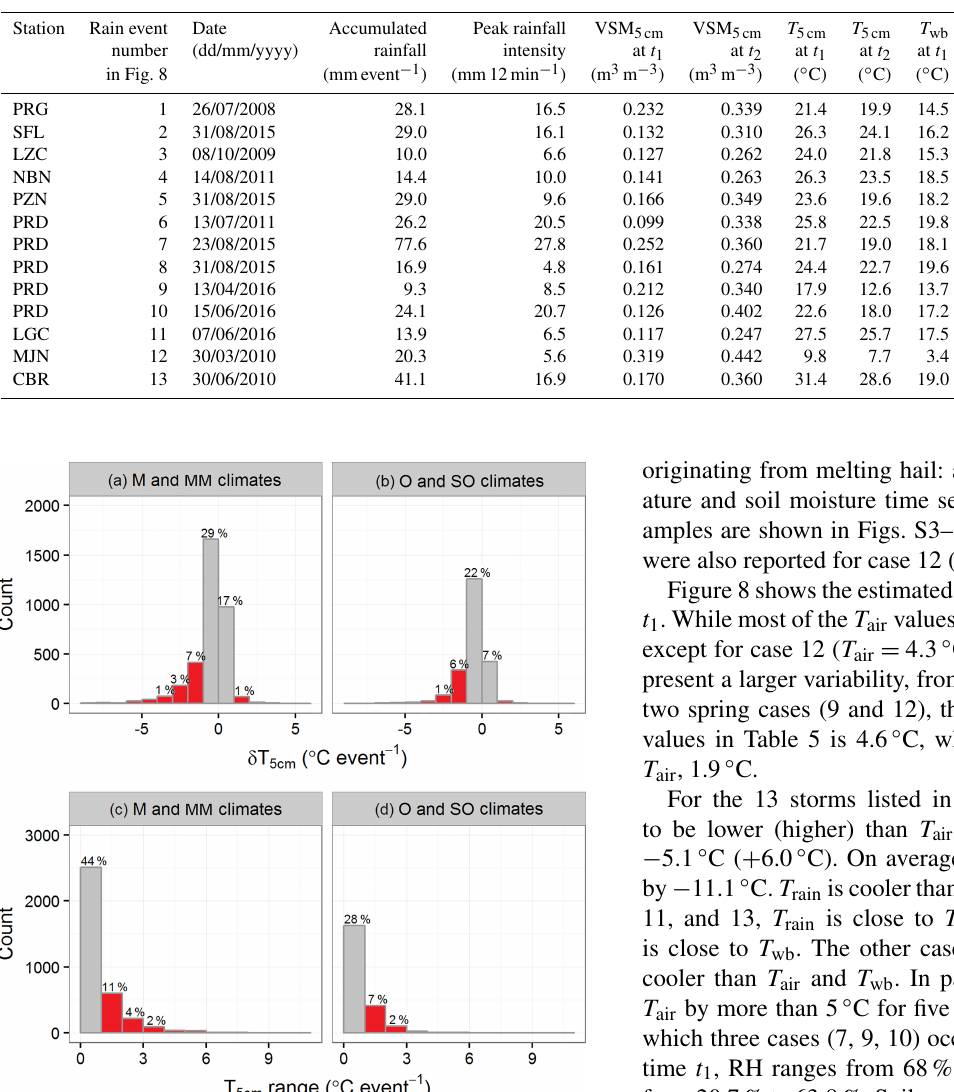
Table 5. The estimated rain temperatures ( T rain ) for 13 intense soil-cooling events, together with the in situ observations of VSM 5cm , T 5cm , T air at time t 1 and t 2 , and T wb at time t 1 . The time lapse from time t 1 to t 2 is 12 min. For rain events 9 and 12, Eq. (4) is used to estimate the amount of melting hail at the soil surface. T rain values lower by − 5 ◦ C than T air at time t 1 are in bold. Stations are listed from west (top) to east (bottom).